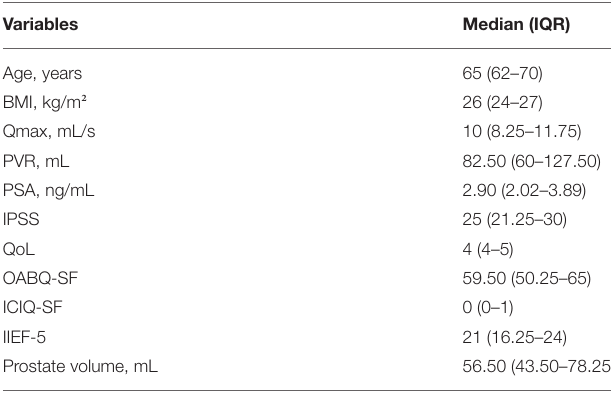
TABLE 1 | Preoperative characteristics of